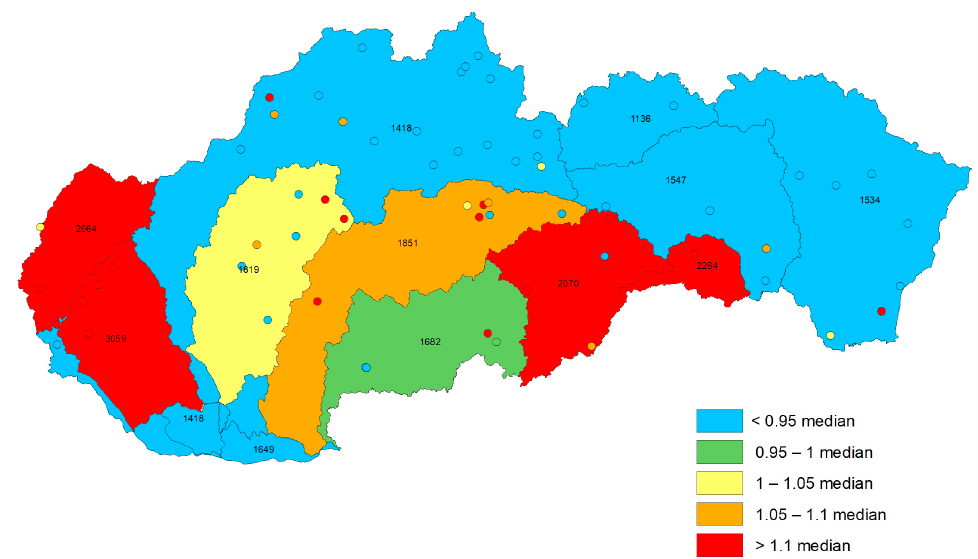
Figure 10. Sub-catchments in Slovakia colored according to the number of days with Q d < Q 355d,rr , 1961–2015. The dots represent the individual WSs and are colored using the same key as the sub-catchments.